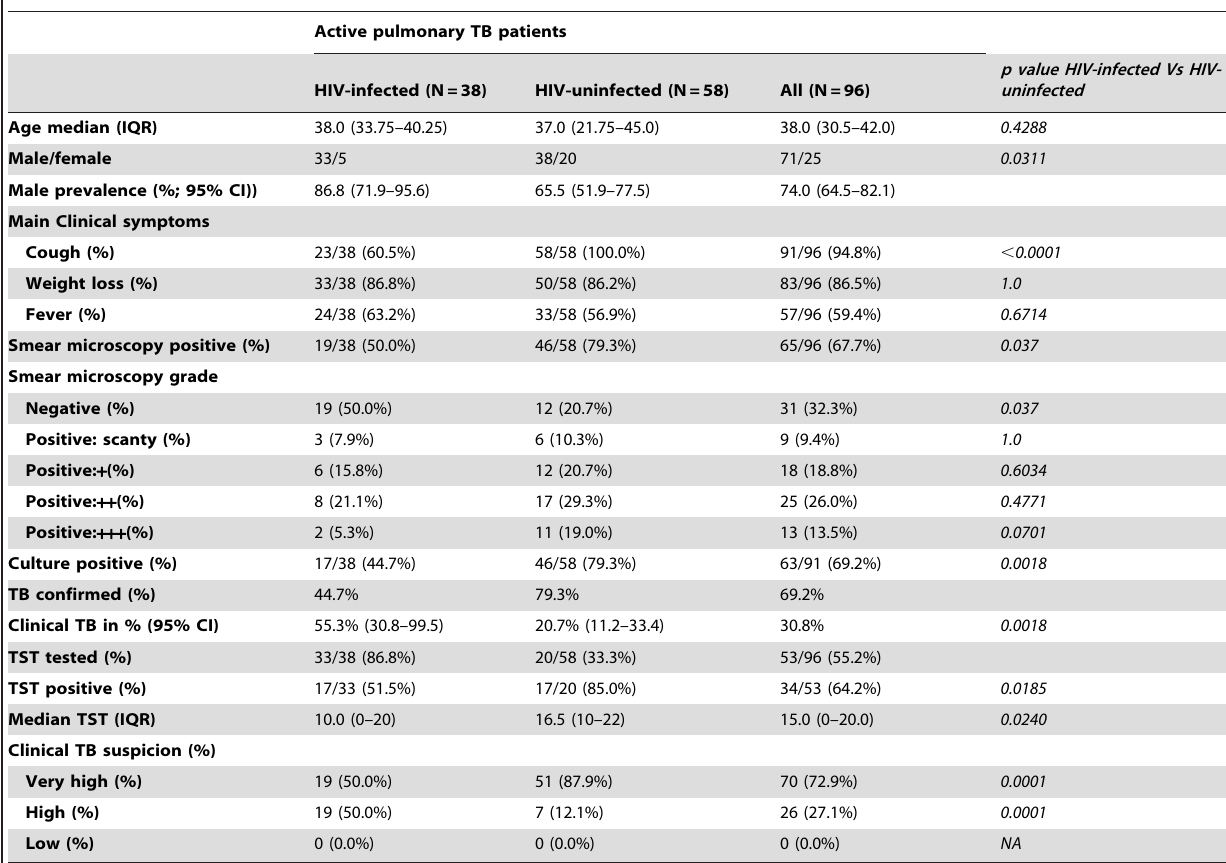
Table 1. Characteristics of the 96 Active Pulmonary TB patients included in the